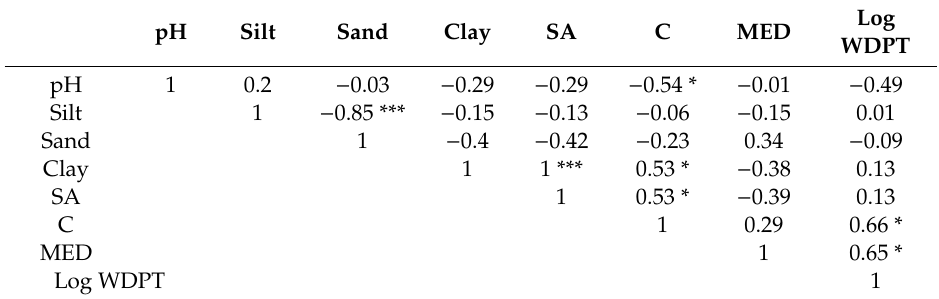
Table 4. Pearson product moment correlation matrix of pH, silt (g g − 1 ), sand (g g − 1 ), clay (g g − 1